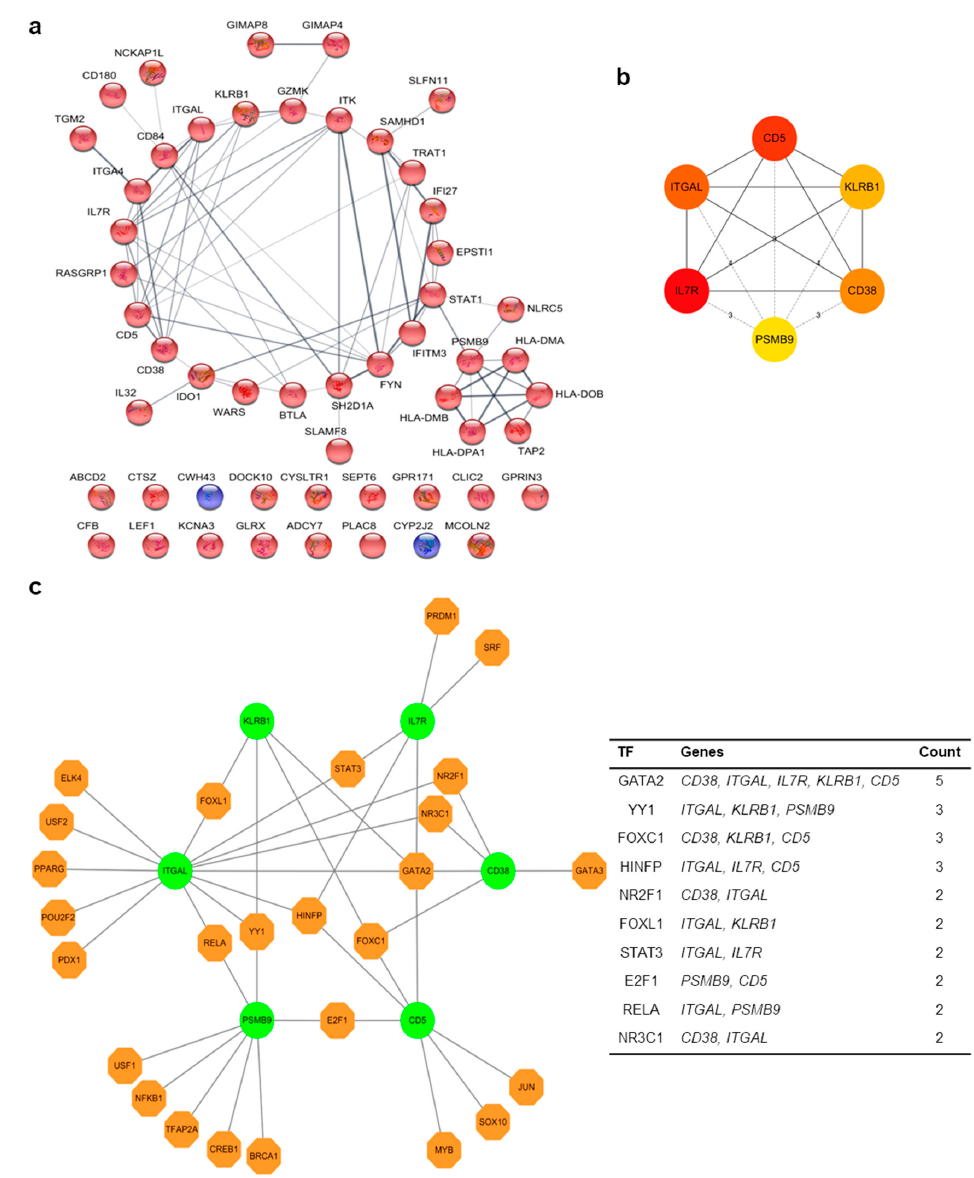
Figure 5. Analysis of hub genes and their putative pathways. ( a ) STRING predicted functional protein interactions of significant genes, both positive and negative. The edge indicates the interaction degree between nodes. The color of nodes means upregulated (red) or downregulated (blue) genes in IC/BPS patients compared to control. ( b ) In this map, hub genes and the top six protein interactions are shown. They were obtained using cytoHubba from Cytoscape. The node color is redder depending on significant interactions. ( c ) Hub gene–transcriptional factor (TF) interaction was analyzed using JASPAR database through NetworkAnalyst. The edge indicates that the hub gene is associated with putative TFs. The color of the node is different depending on the roles; green is the hub gene and orange is the TF.